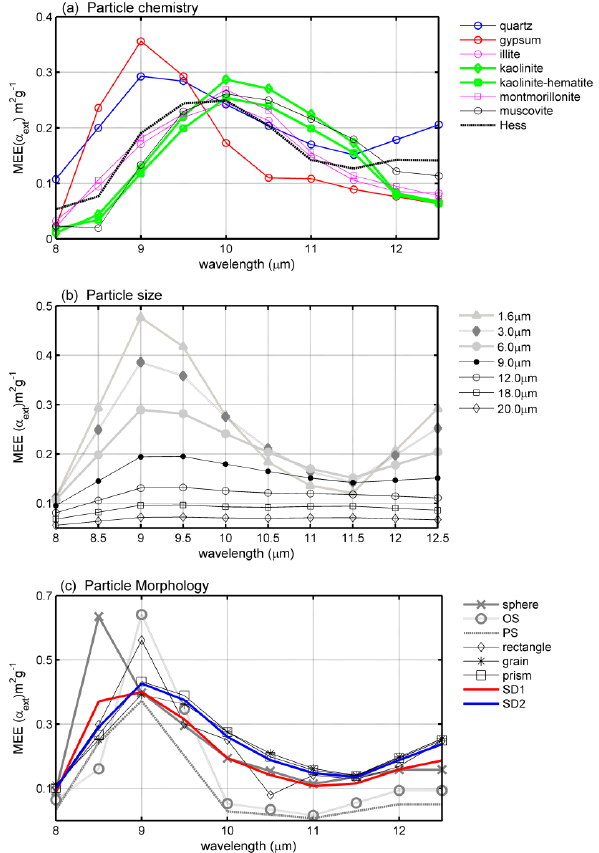
Fig. 8. Sensitivity of MEE to dust microphysics and chemistry (a) particle chemistry, (b) particle size (VMD), and (c) particle mor- Figure 8 sensitivity of MEE to dust microphysics and chemistry (a) particle chemistry, phology. SD1 and SD2 are the particle shape distribution scenarios. (b) particle size (VMD), and (c) particle morphology. SD1 and SD2 are the particle See text for shape distribution scenarios. See text for details.